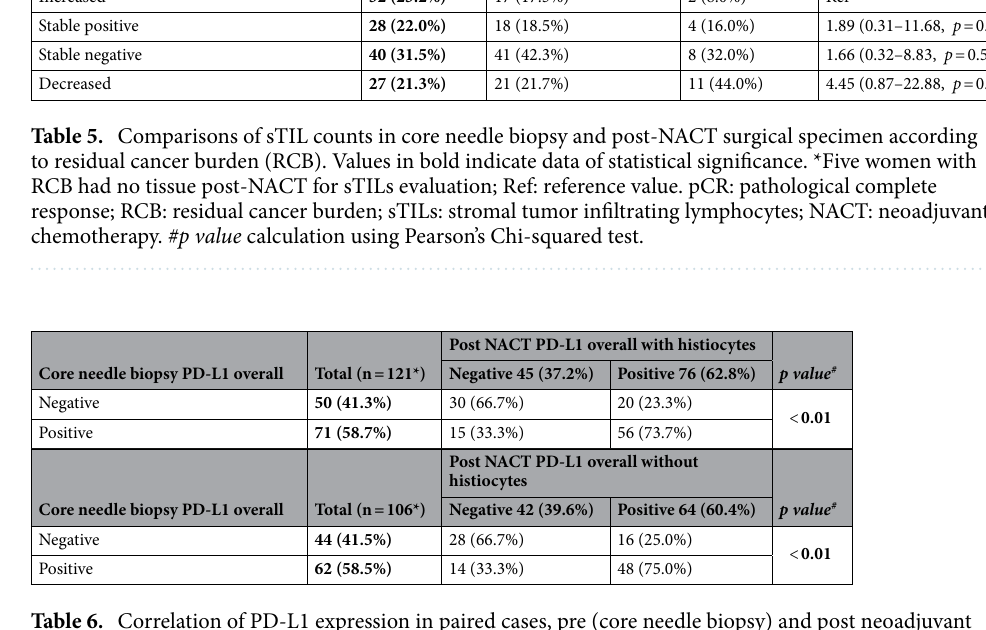
Table 6. Correlation of PD-L1 expression in paired cases, pre (core needle biopsy) and post neoadjuvant chemotherapy. Values in bold indicate data of statistical significance. *Six women (two with pCR and four with RCB) had no tissue post-NACT for immunohistochemical evaluation; NACT: neoadjuvant chemotherapy; # p value calculation using McNemar’s paired